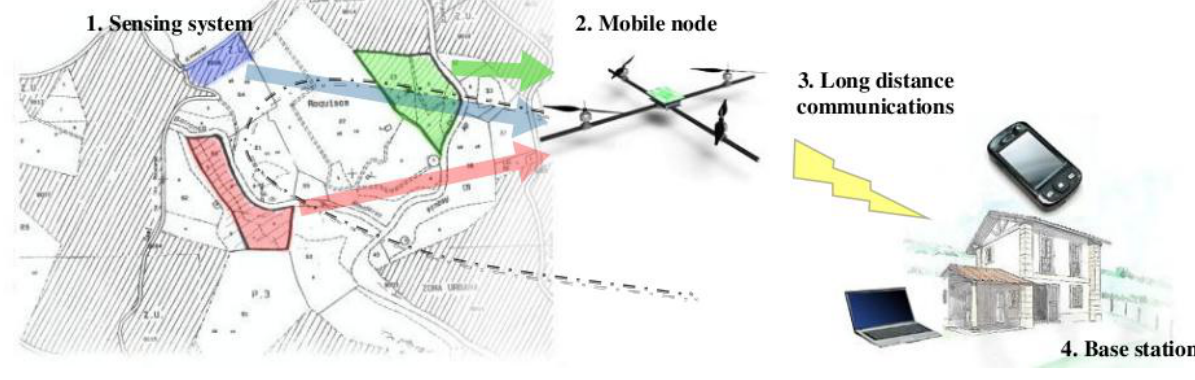
Figure 3. An illustrative example of the overall remote sensing